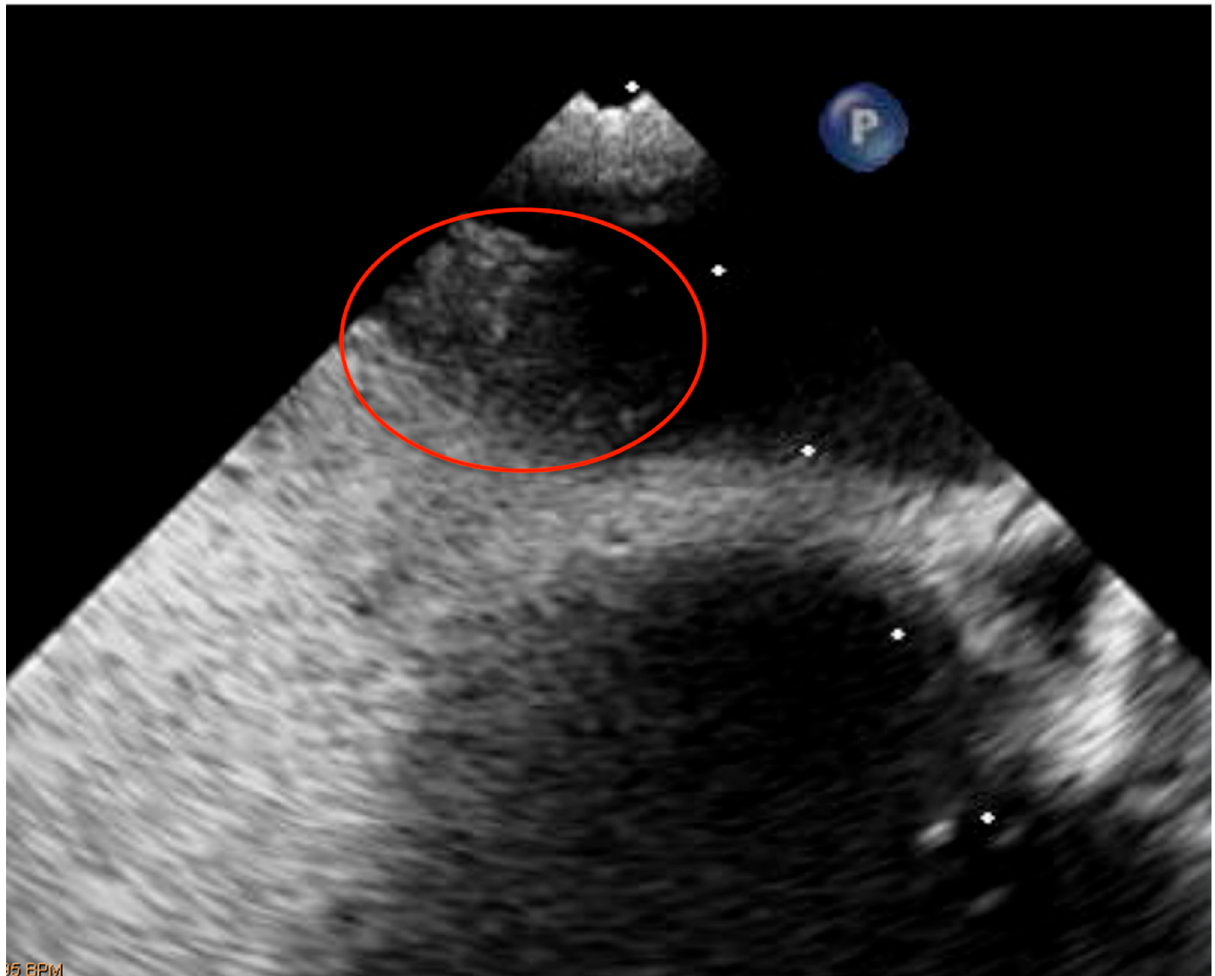
Figure 3. The echocardiographic image displays a secundum atrial septum defect with patent foramen ovale (PFO).